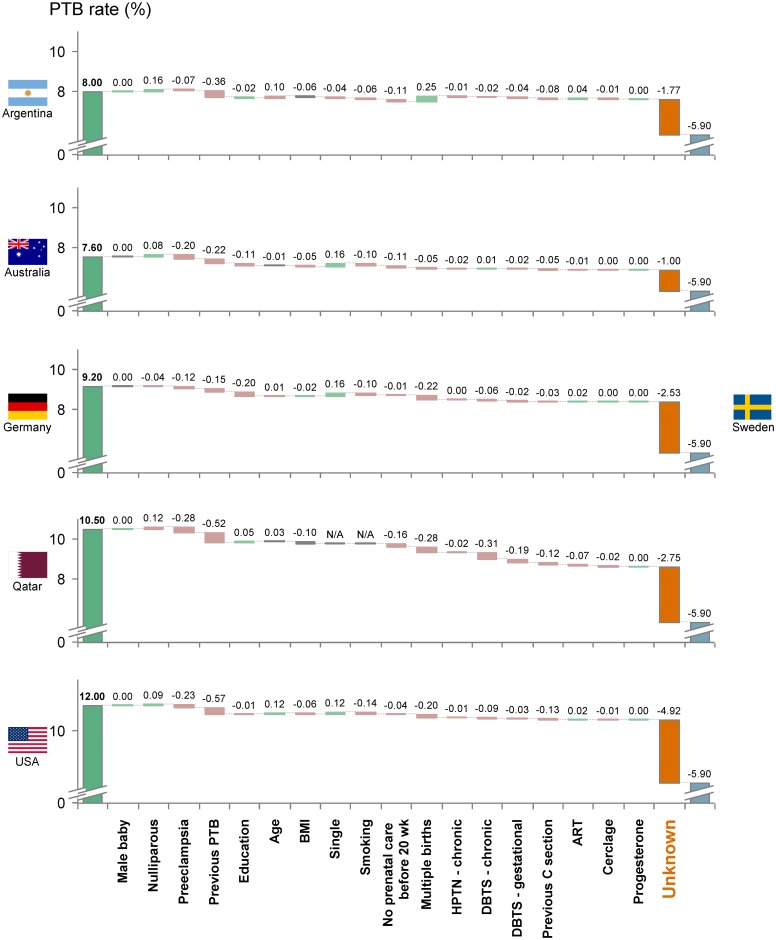
Estimated contributions of risk factors and clinical practices to differences in preterm birth rates between countries with VHHDI (left) and Sweden (right).The left and right bars represent the preterm birth rates for the indicated countries [5]. The size of each step in the “waterfall” was calculated by taking the difference in the estimated impact of risk factor (or clinical practice) between the indicated country and Sweden. The last step, labeled "unknown", represents the percentage not captured by the risk factors and clinical practices shown here. "N/A" indicates that information was not available to estimate the impact of the risk factor. Results for additional countries are shown in Fig F of S1 Appendix. Abbreviations: PTB, preterm birth; HPTN, hypertension; DBTS, diabetes; ART, assisted reproductive technology; 20 wk, 20 weeks.